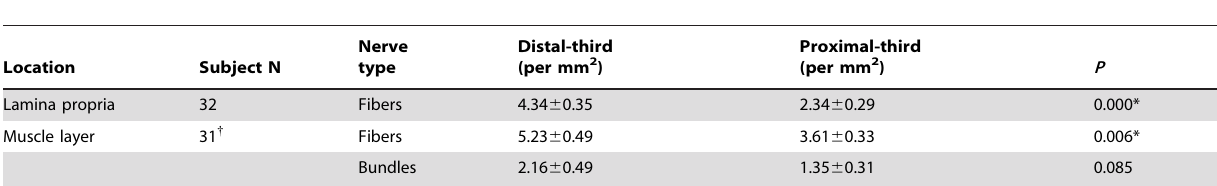
Table 1. Vaginal innervation according to location (alpha =0.05, two-tailed).